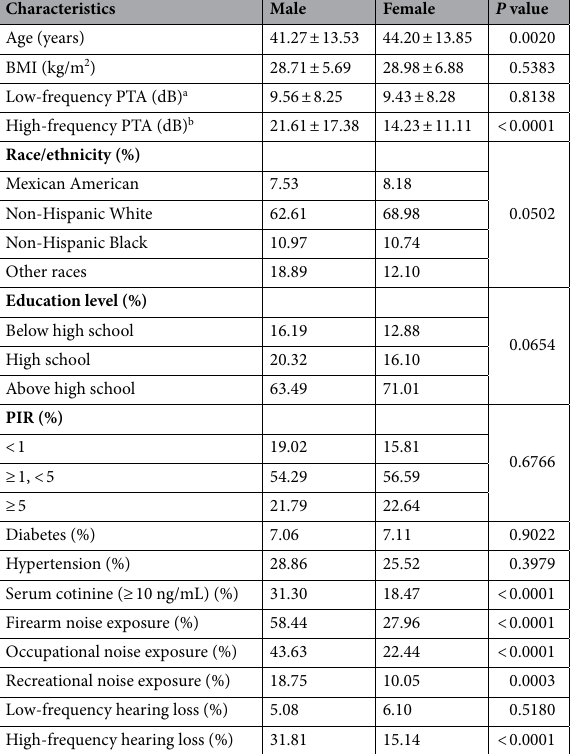
Table1. The weighted demographic characteristics of study participants. Values are weighted means ± SD for: age, BMI, low-frequency PTA, high-frequency PTA. P value was calculated by weighted linear regression model. % for: race/ethnicity, education level, PIR, diabetes, hypertension, serum cotinine, firearm noise exposure, occupational noise exposure, recreational noise exposure, low-frequency hearing loss, high- frequency hearing loss. P value was calculated by weighted chi-square test. Created by EmpowerStats (www. empow ersta ts. com) and R. a Mean PTA at 0.5, 1, and 2 kHz of both ears. b Mean PTA at 3, 4, 6 kHz of both